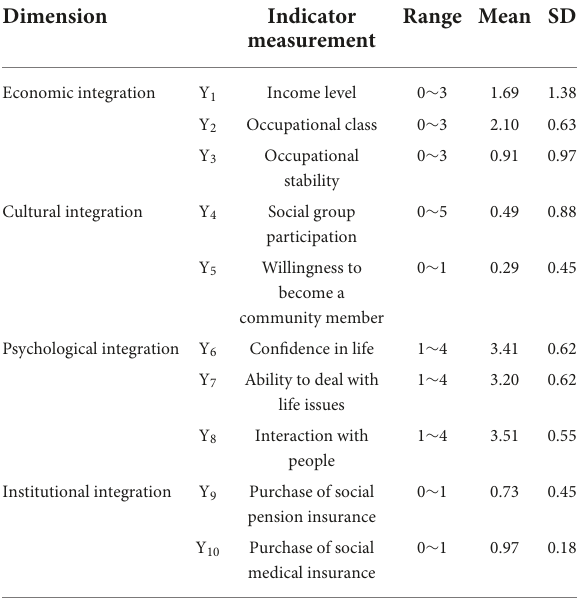
TABLE 1 Descriptive statistics of social integration indicators.